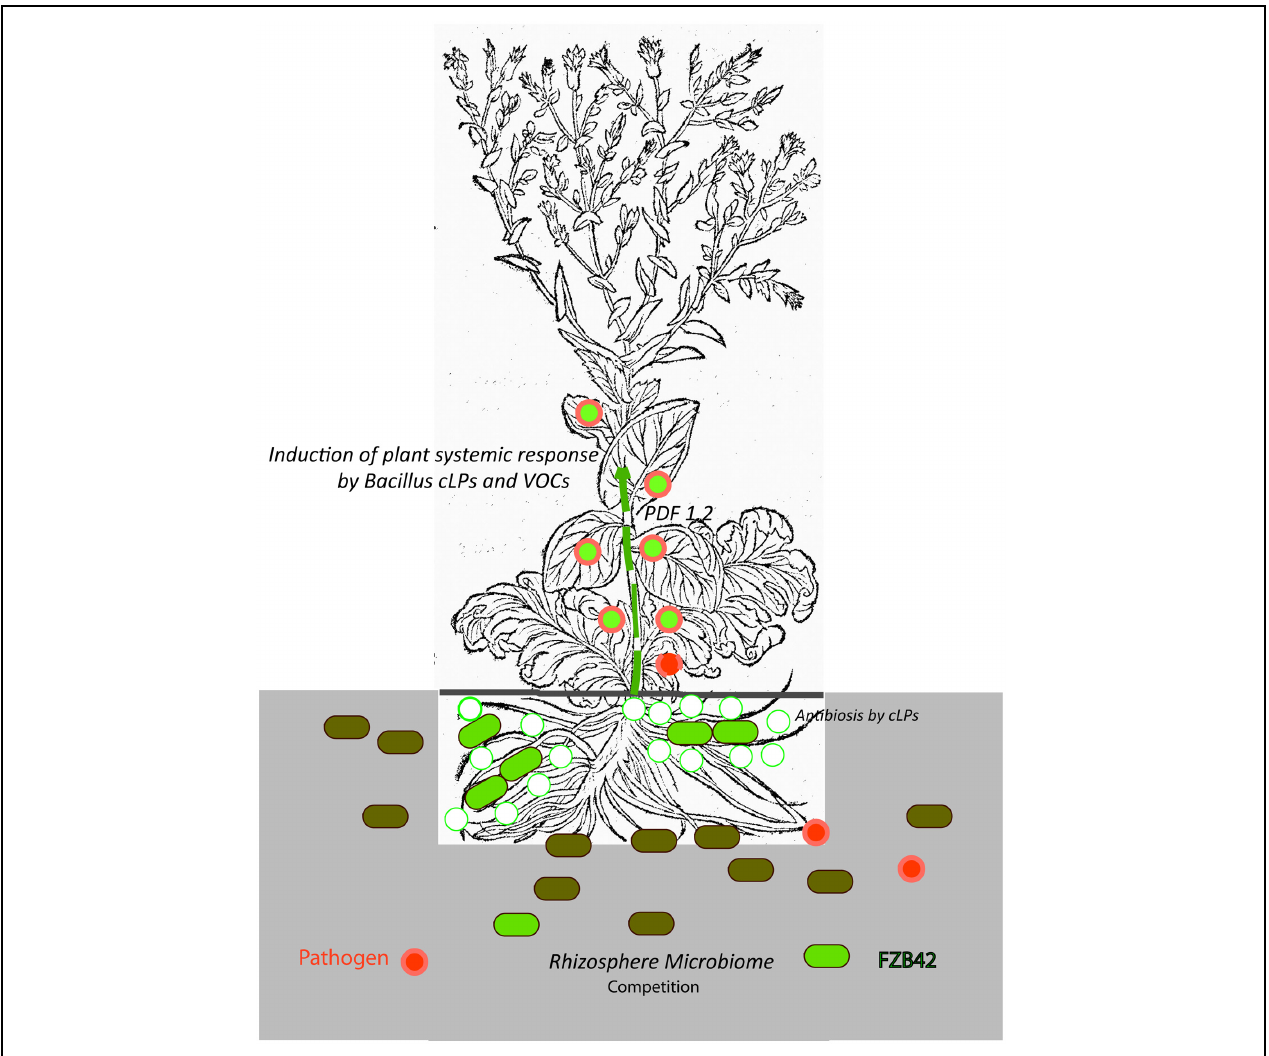
FIGURE 5 | Biological control exerted by the plant-beneficial bacterium FZB42. The cartoon illustrates our present picture about the complex interactions between a beneficial Gram-positive bacterium (FZB42, light green), a plant pathogen ( R. solani, symbolized by red filled circles) and plant (lettuce, Lactuca sativa ). FZB42 colonizes the root surface and is able to produce non-ribosomally cyclic lipopeptides, mainly surfactin and bacillomycin D and to a minor extent fengycin as indicated by the green circles (Chowdhury et al., 2015). It is very likely, but not shown until now, that VOCs (e.g., acetoin, 2,3-butandiol), and small peptides (e.g., plantazolicin, amylocyclicin) are also produced in vicinity of plant roots. Direct antibiosis and competition for nutrients